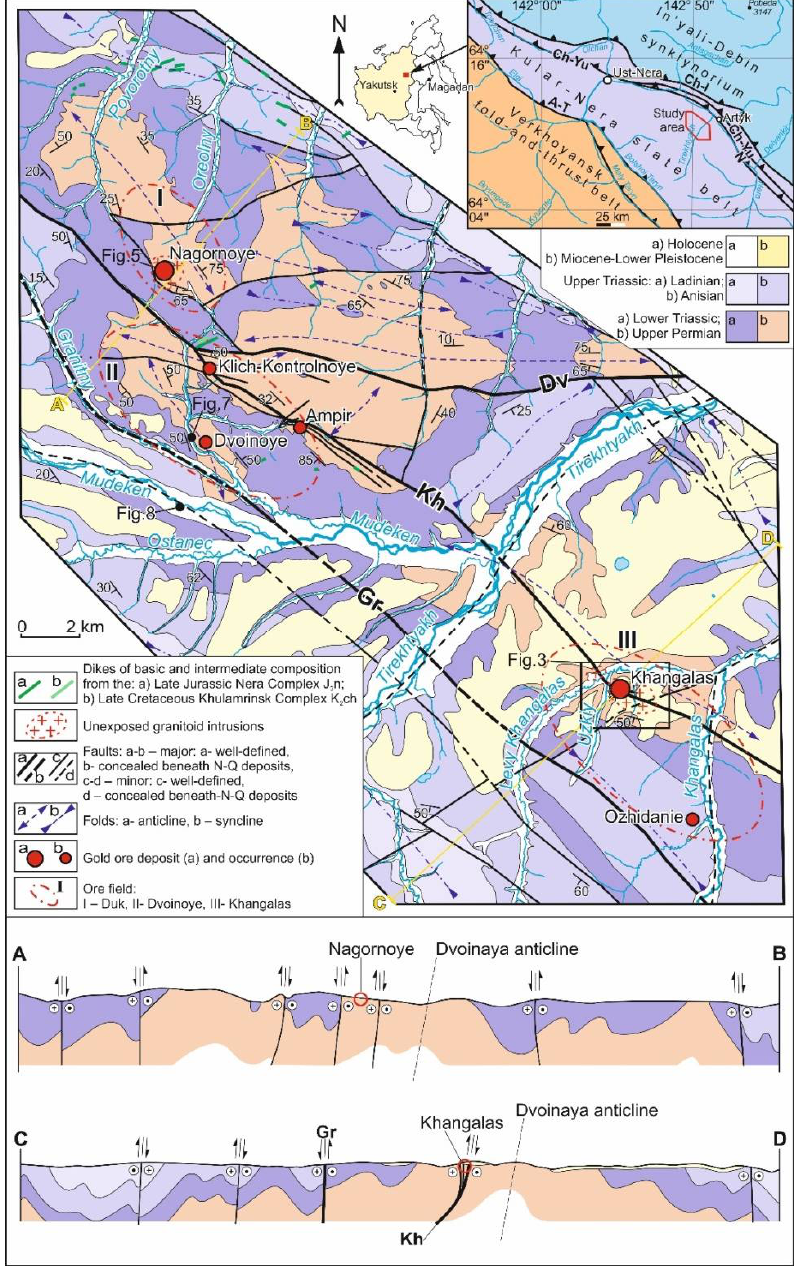
Figure 1. Geological sketch map, sections and location of gold deposits and occurrences of the Khangalas ore cluster, modified and supplemented from [2] . The inset map shows the position of the Khangalas ore cluster. Faults: Ch-I, Charky-Indigirka; Ch-Yu, Chai-Yureye; N, Nera; A-T, Adycha-Taryn.